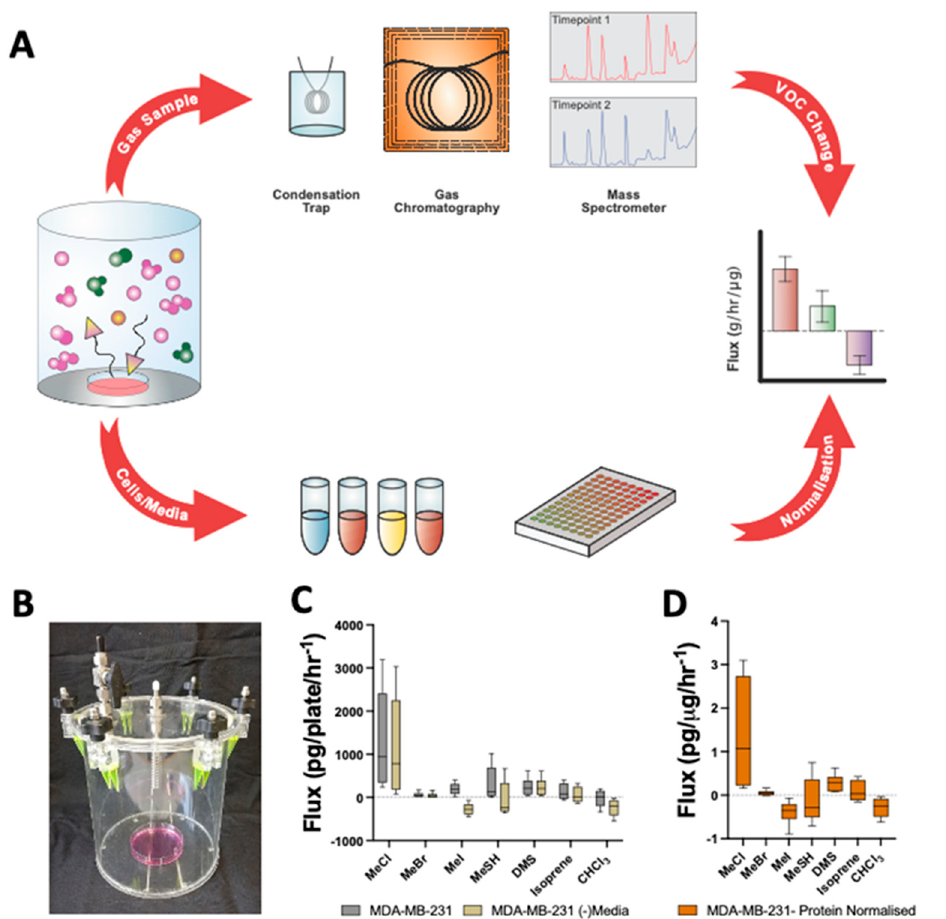
Figure 1. Direct volatile sampling of cellular headspace. ( A ) Schematic overview for methodological approach; headspace sampling and generation of VOC flux. ( B ) Image of collection chamber. ( C ) Selected volatile fluxes (g/h/plate) for 10 cm dishes containing DMEM media control only